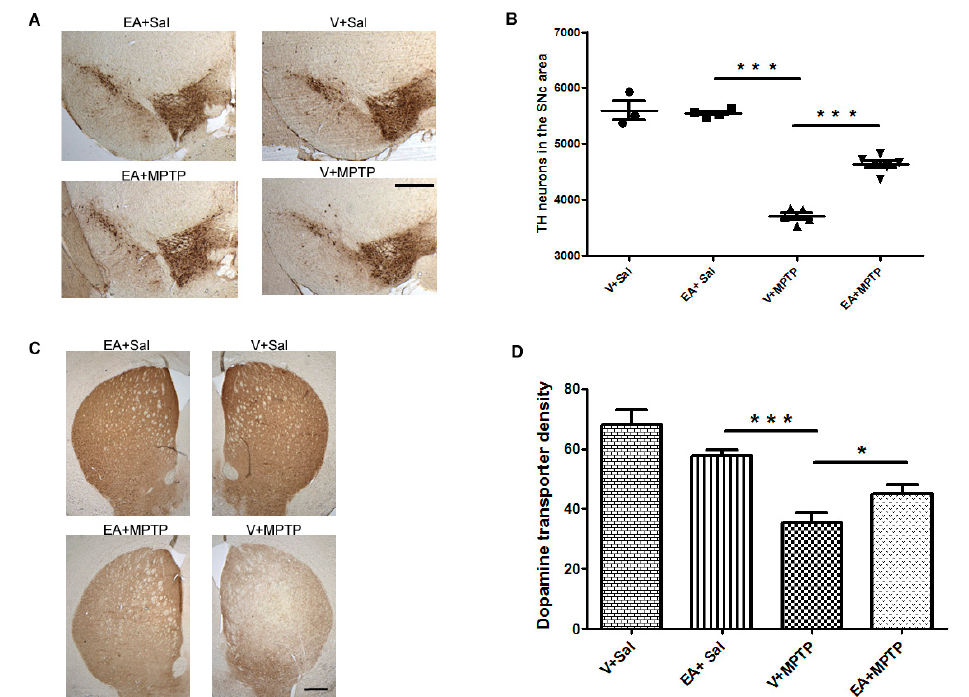
Figure 1. Immunostaining of tyrosine hydroxylase immune-positive (TH + ) neurons to quantify the number of dopaminergic (DA) neurons in the substantia nigra (SNc) and dopamine transporter (DAT) in the striatum. ( A ): Representative images showing the TH + neurons in the SNc area. ( B ): The number of DA neurons in the SNc was counted in each animal using unbiased Stereo Investigator system as described in Section 2. The number of DA neurons was significantly higher in the SNc of the control group (V + Sal) when compared to the MPTP-injected group (V + 1-methyl-4-phenyl 1,2,3,6 tetrahydropyridine (MPTP)). The ellagic acid (EA) treatment significantly prevented the DA neurons from the MPTP-induced neurodegeneration ( n = 3–6 animals). ( C ): Representative images showing the immunoreactivity of dopamine transporter (DAT) in the striatum. The intensity of dopamine nerve terminals was significantly reduced in the striatum of MPTP-injected mice when compared with that in the control (V + Sal) group. Treatment with EA prior to MPTP injection shows significant attenuation of dopamine nerve terminals intensity. ( D ): DAT intensity was measured using NIH image J software and is presented in the graph. Values are expressed as a percentage of mean ± SEM relative to 100% control ( n = 3–5 animals). The scale bar is 400 µm. Significance is denoted as * p < 0.05 and *** p < 0.001.